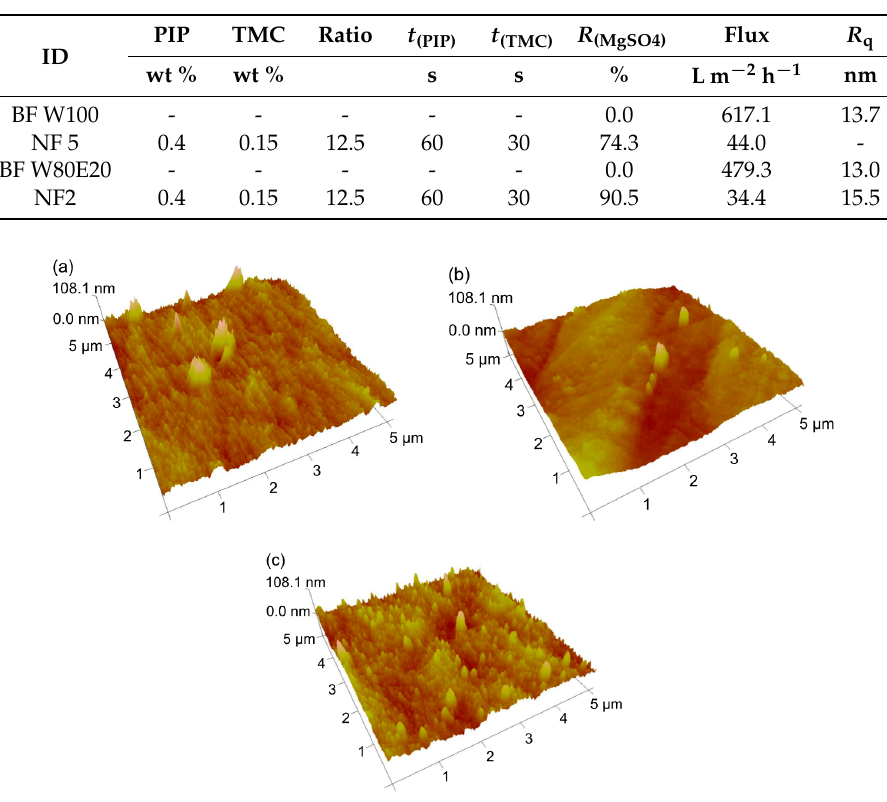
Figure 4. Three-dimensional atomic force microscopy (AFM) images of the inner surface of fabricated MCM; ( a ) uncoated MCM with ID W80E20; ( b ) uncoated MCM with ID W100; ( c ) composite MCM with ID NF2.